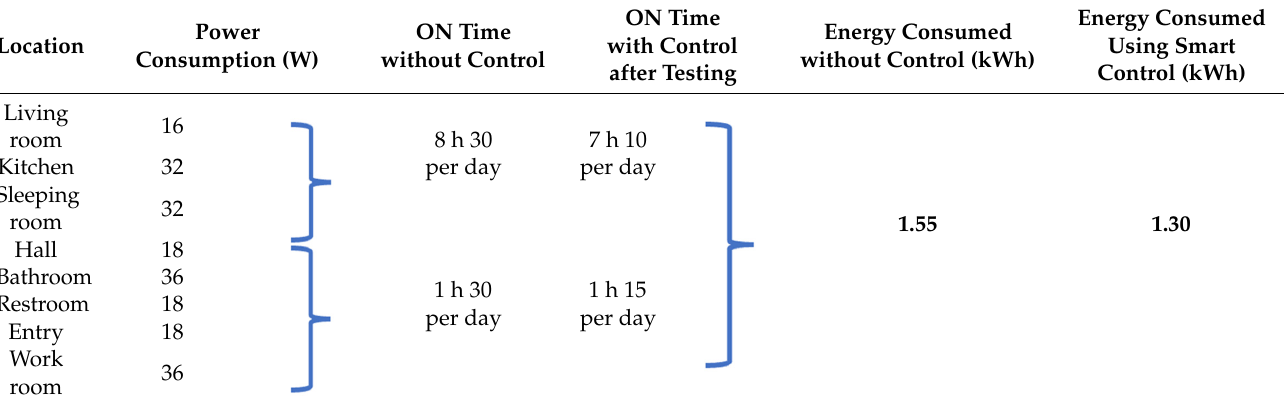
Table 4. Lighting energy consumption of UDES’ solar smart house with and without smart control.